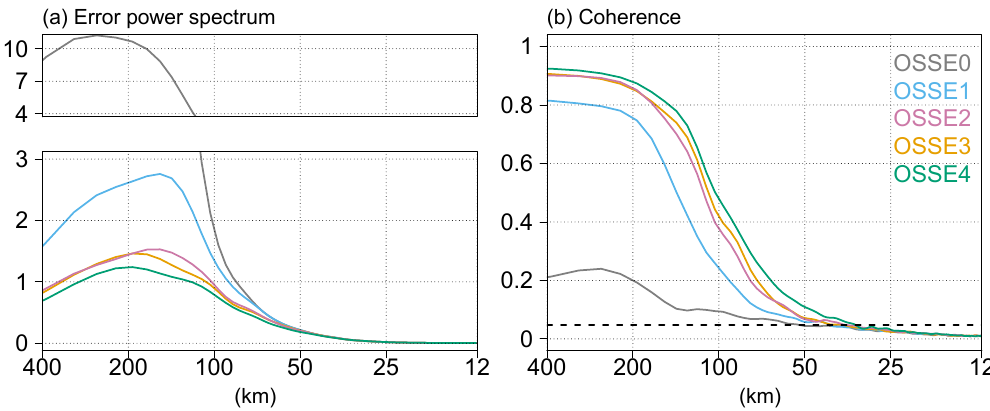
Figure 7. Spectral Analysis of the SSH signals in the OSSEs considering an open ocean region ( − 19 ◦ W, − 10 ◦ W; 46 ◦ N, 55 ◦ N) represen- tative of the North Atlantic Drift, during the period from February to December 2009. The results for the OSSE0 (gray lines), OSSE1 (blue lines), OSSE2 (purple lines), OSSE3 (orange lines) and OSSE4 (green lines) experiments, are shown in the spectral window between 400 and 12km. (a) Power spectra of the SSH error with respect to the NR; the spectra are shown in a variance preserving form (cm 2 ). (b) Spectral coherence in the OSSEs with respect to the NR; the black dashed line shows the 95% confidence interval (Thomson and Emery,